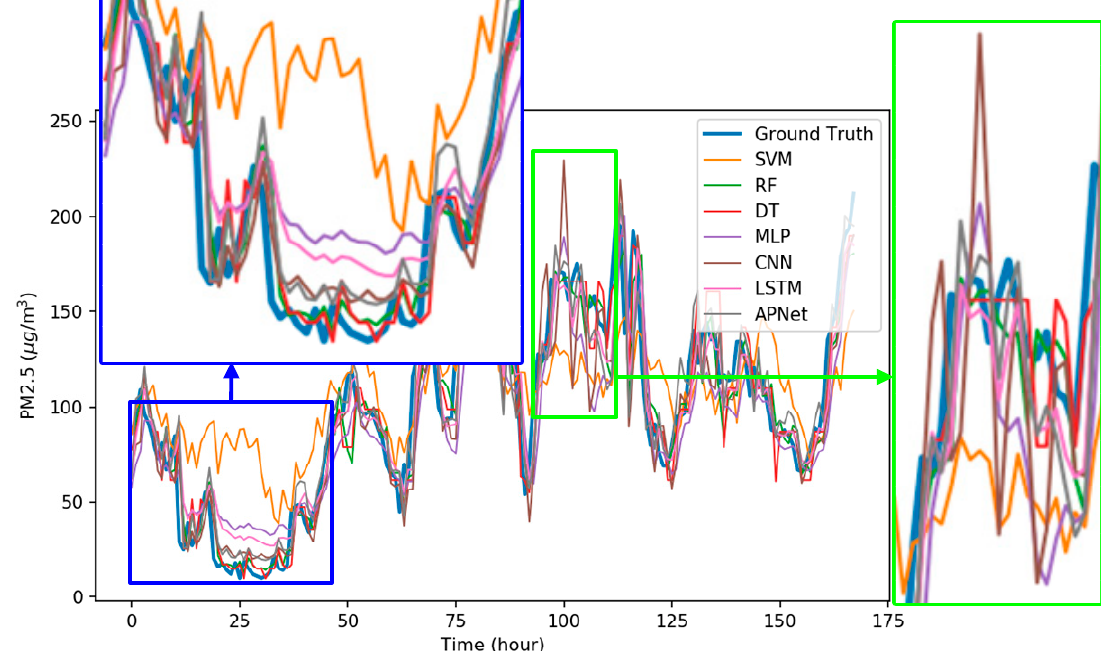
Figure 9. The comparisons details of forecasting results.